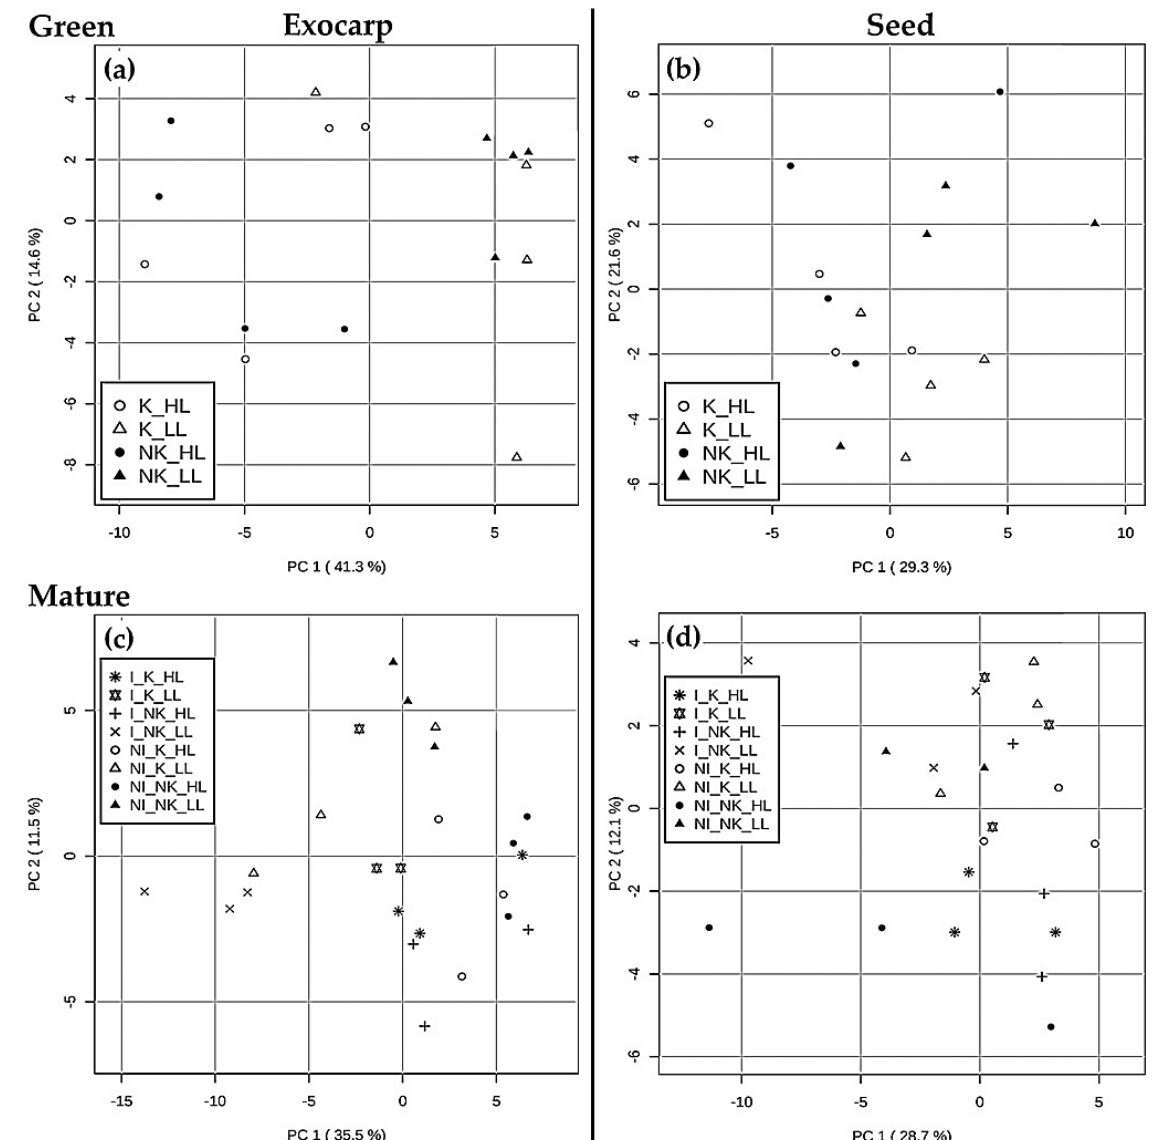
Figure 2. Principal component analysis (PCA) score plots based on the LCMS metabolite data for both exocarp ( a , c ) and seed ( b , d ) at the two most contrasting ripening stages ( a , b —green and c , d —mature), including all microclimates and treatments ( n = 4 for green stage and n = 3 for mature stage). The abbreviations in the legend represent: NI—Non-Irrigation; I—Irrigation; NK—Non-kaolin; K—Kaolin; LL—Low Light microclimate; HL—High Light microclimate.